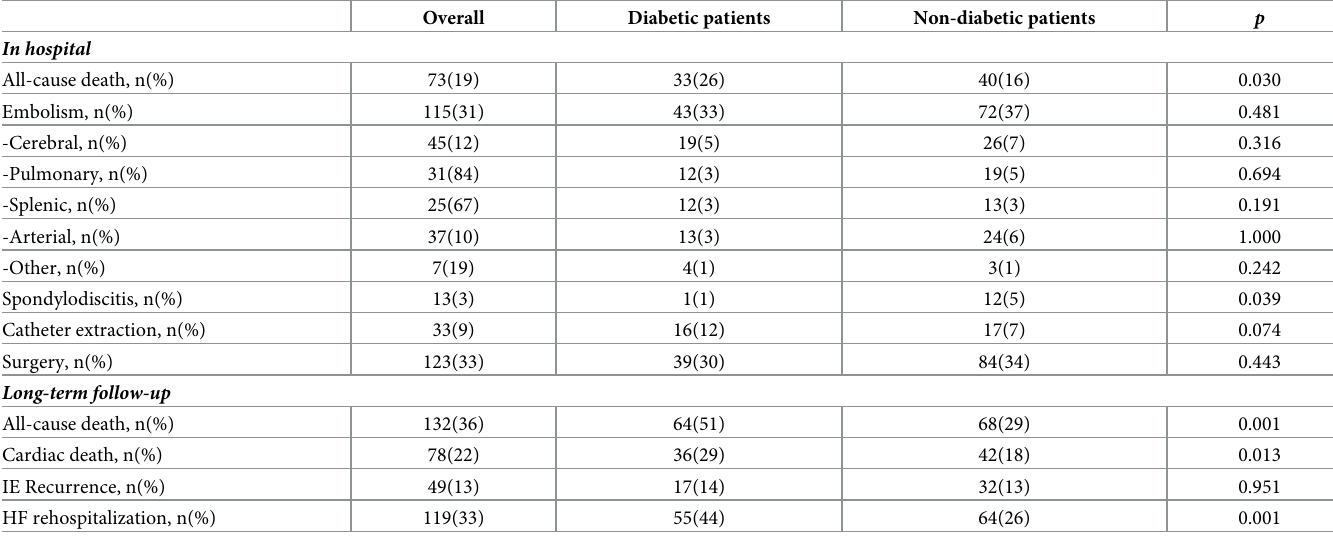
Table 4. Clinical events in-hospital and at